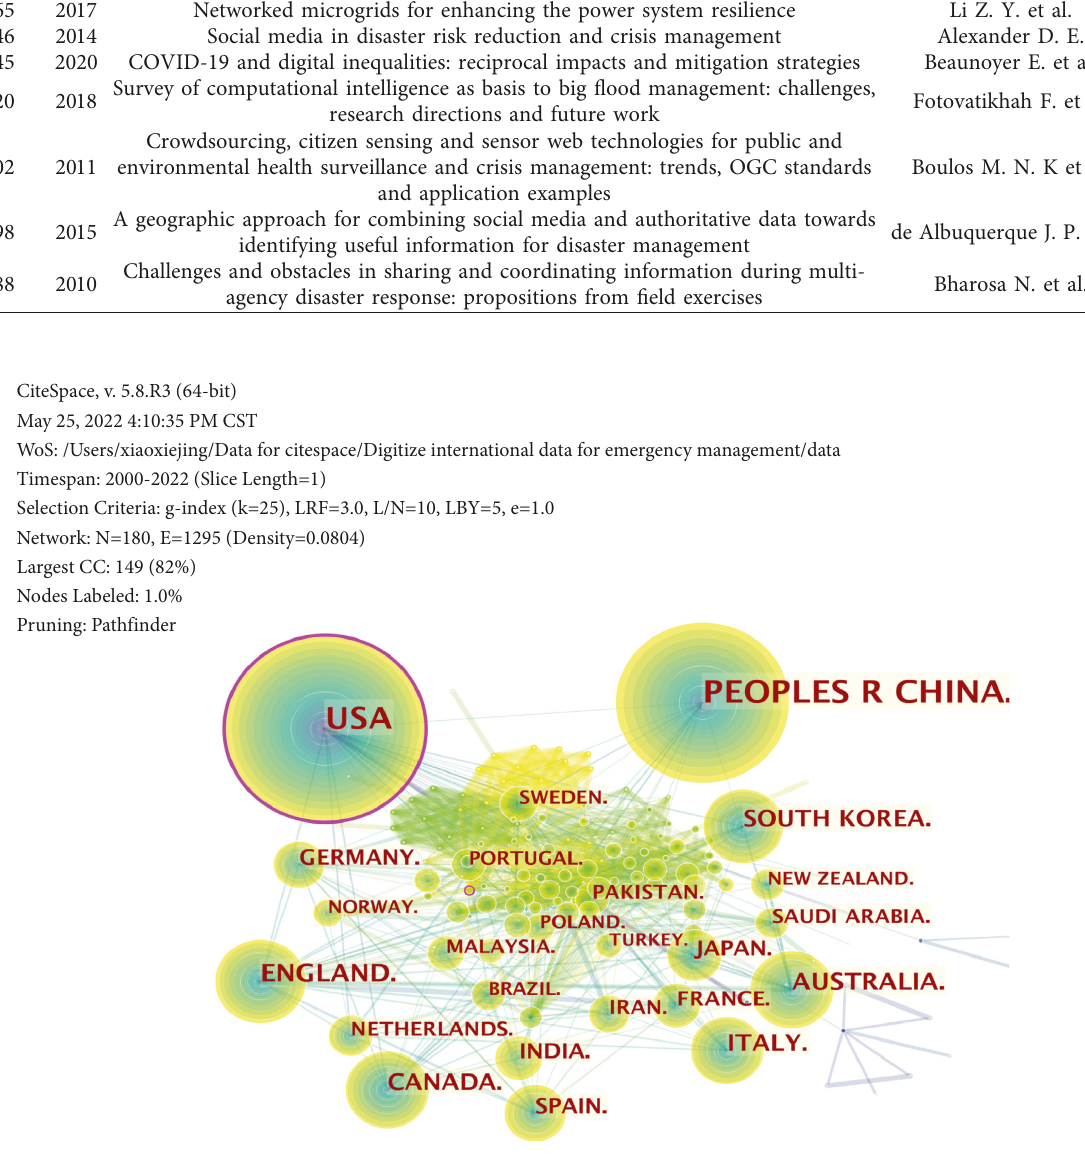
Figure 3: Countries’ cooperation network of DEM